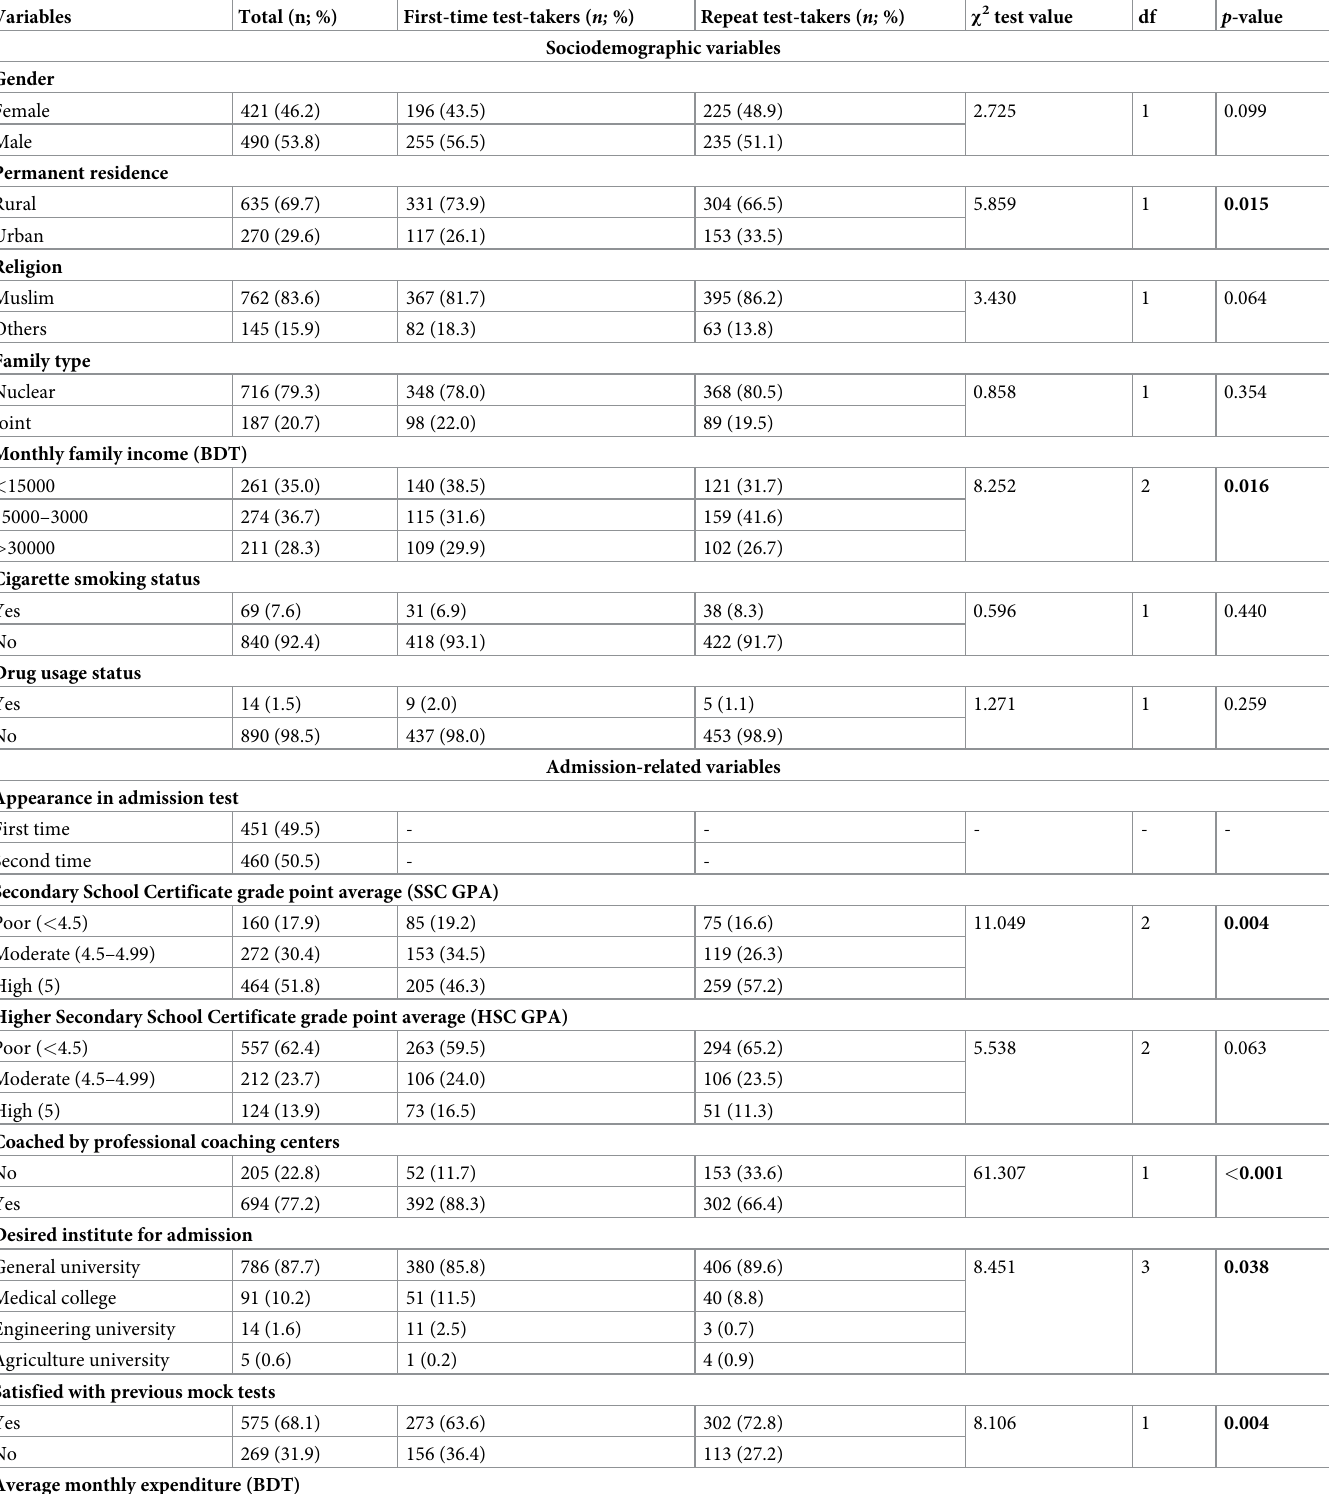
Table 1. Distribution of the variables among first-time and repeat university entrance